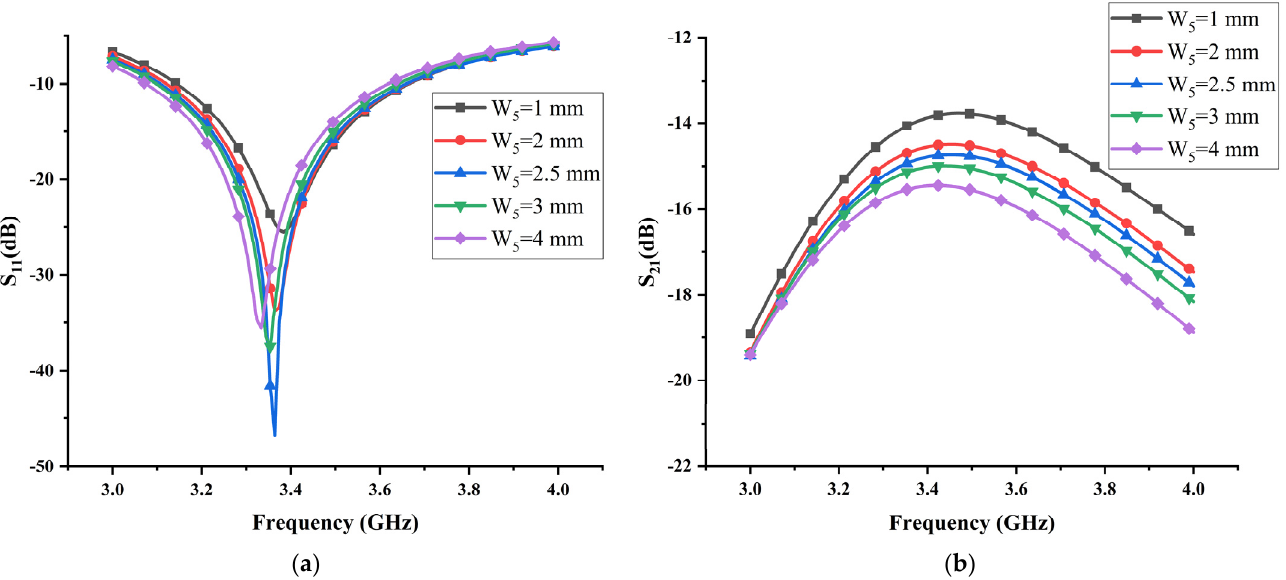
Figure 6. The effects of the width of the I-shaped ground branch W 5 on ( a ) reflection coefficient and ( b ) transmission coefficient.